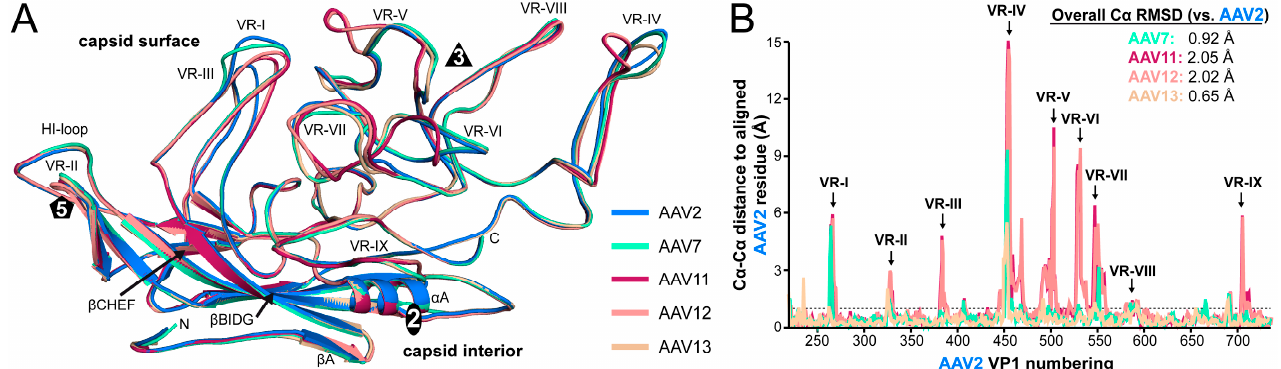
Figure 4. Structural comparison of AAV2, AAV7, and AAV11–13. ( A ) Structural superposition of AAV2 (blue), AAV7 (cyan), AAV11 (burgundy), AAV12 (salmon), and AAV13 (wheat) shown as ribbon diagrams. The positions of β -strands, the N- and C-terminus, the variable regions (VRs), and the icosahedral 2-, 3-, and 5-fold axis are indicated. This figure was generated using PyMol [60]. ( B ) C α –C α distance plot (in Å) for the AAV7 and AAV11–13 residues relative to AAV2 of the superposed viral protein (VP) structures. The VRs are indicated and the overall VP C α -RMSD (root mean square deviation) compared to AAV2 shown. The dashed line marks the C α –C α distance variation of 1 Å.